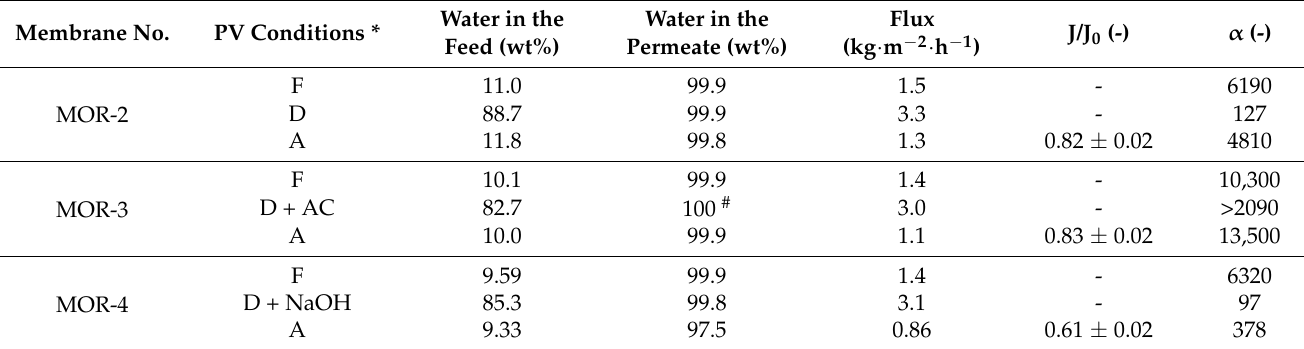
Table 4. Influence of distillate pretreatments on the dehydration performance of MOR membranes. Membrane No.